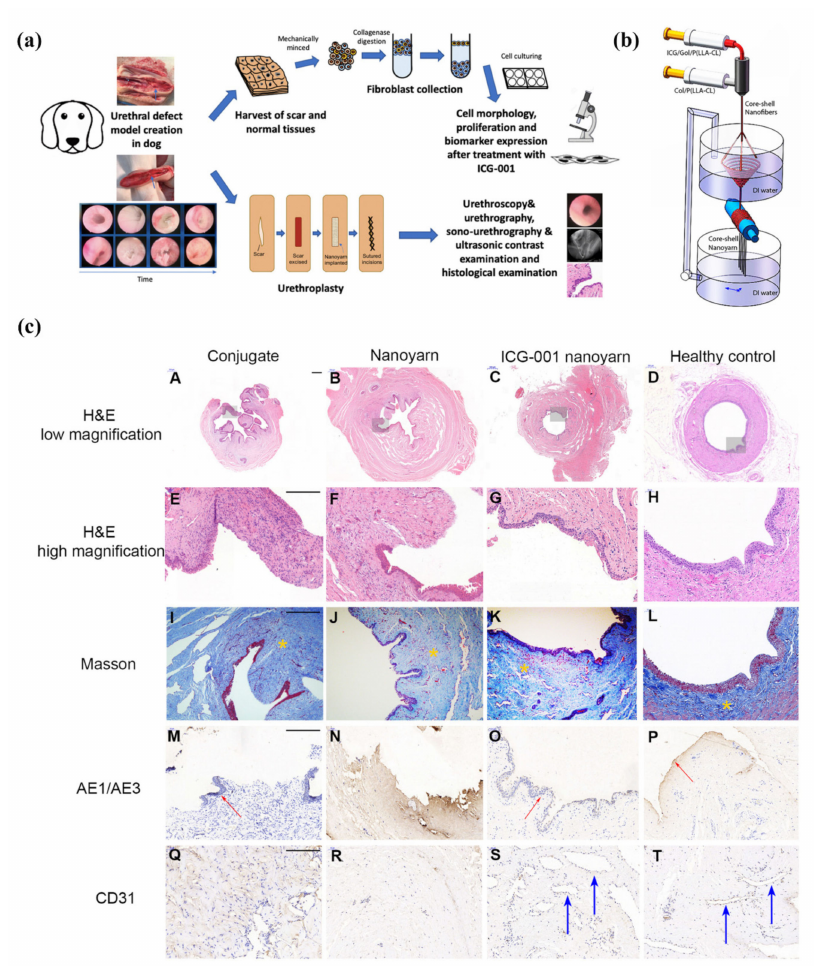
Figure 5. ( a ) Study design of using ICG-001 loaded collagen/poly(L-lactideco-caprolactone) nanoyarn to treat urethral defects in a canine model; ( b ) fabrication process of ICG-001 deliv- ered collagen/poly(L-lactideco-caprolactone) nanoyarn; ( c ) hematoxylin and eosin (A–H), Masson trichrome (I–L), AE1/AE3 (M–P) and CD31 (Q–T) staining of urethras in each group at 12 weeks post urethroplasty. H&E, hematoxylin and eosin. Red arrows indicate the epithelium in (M,O,P). Blue arrows indicate vessels in (S,T). Yellow asterisks indicate ECM in (I–L). Adapted with permission from [143], published by Frontiers,